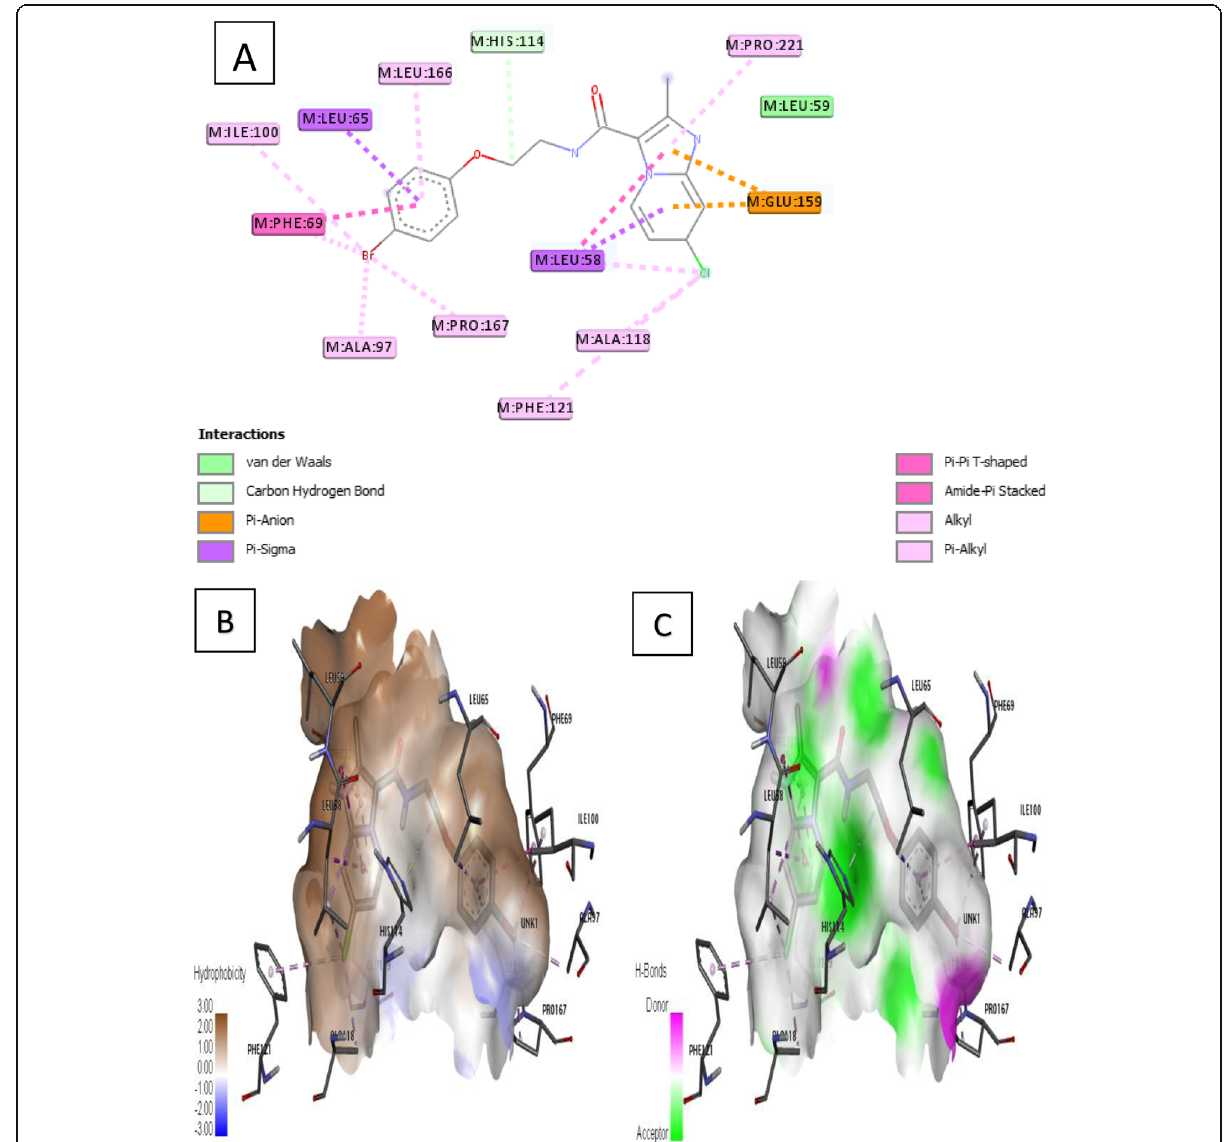
Fig. 7 Docking interaction of complex 7. a 2D docked view of complex 7. b Hydrophobicity surfaces of complex 7. c Hydrogen bond surfaces of complex